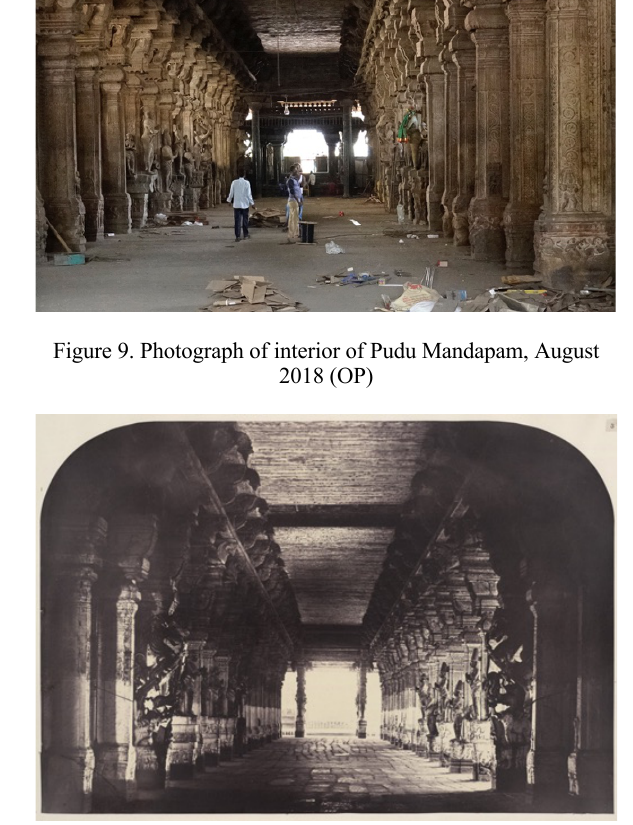
Figure 10. View of the nave from the Simhasanum at the west end. Date: 1858, Linnaeus Tripe © British Library Board Shelfmark: Photo